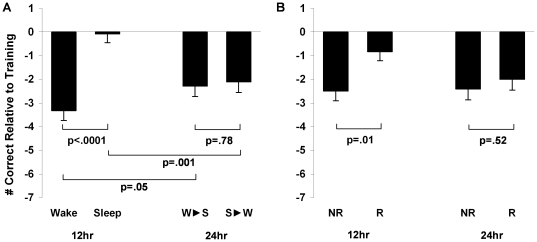
Sleep and Reward effects.A. Sleep v. Wake performance at 12 and 24 hrs. B. Reward v. No-Reward performance at 12 and 24 hrs. Bars represent change in recall collapsed across reward condition (means±SEMs).